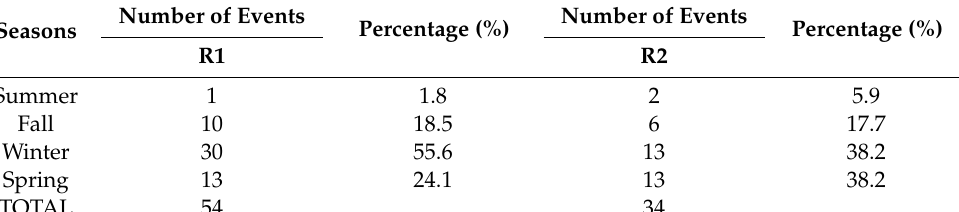
Figure 4. Box plot of the persistence distribution (days) of Tmax above the threshold in regions ( a ) 1 and ( b ) 2. The horizontal blue line represents the 90% percentile of persistence and the red circles represent the extreme values.